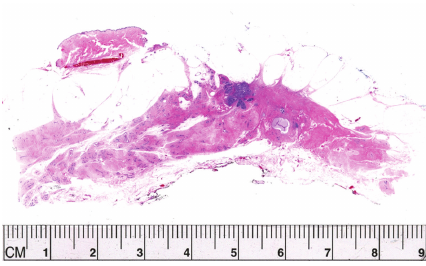
Figure 6: Example of “concentric regression” of tumor after neoad- juvant chemotherapy. She started with a 1.5cm high grade (8/9 MBRS) invasive ductal carcinoma. After neoadjuvant chemother- apy she has a 0.6cm focus of residual tumor.